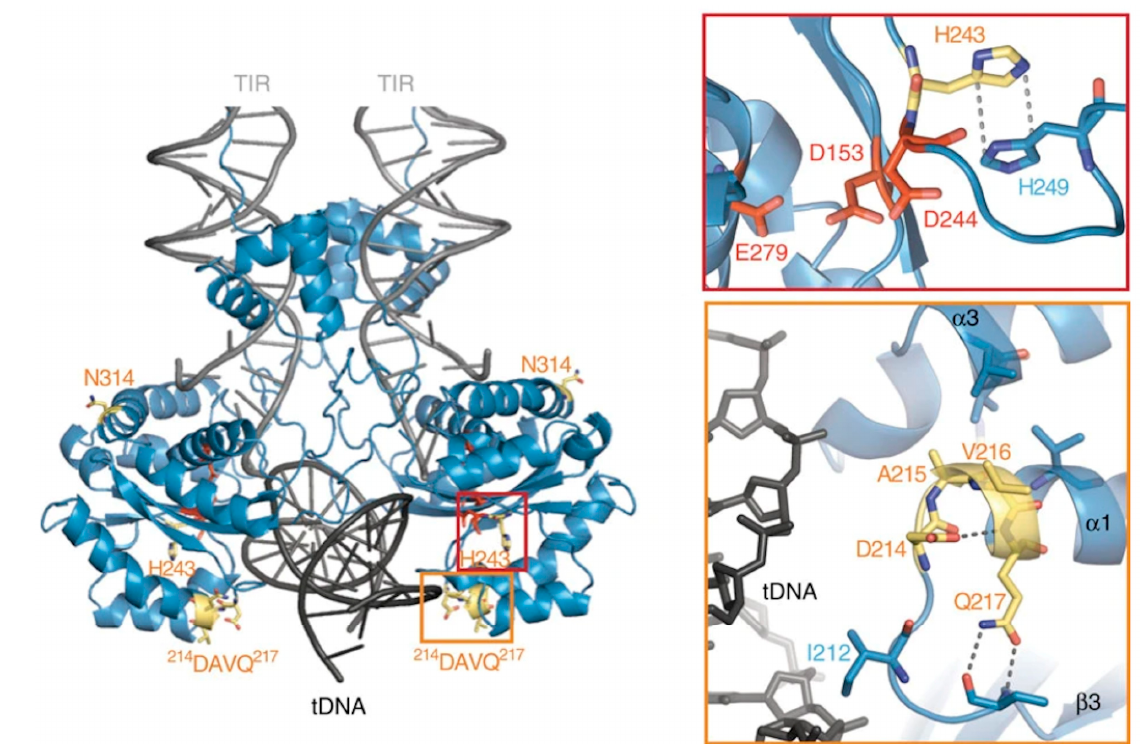
Figure 6. Rationalizing the hyperactive mutations of SB100X. The DAVQ (aa 214–217) mutations (highlighted in yellow box) target the binding groove of the target DNA (tDNA). The H243 mutation (highlighted in red box) together with H249 helps to position D244 in the active site of the transposase. Reprinted from Nature Communications [23] with permission from the